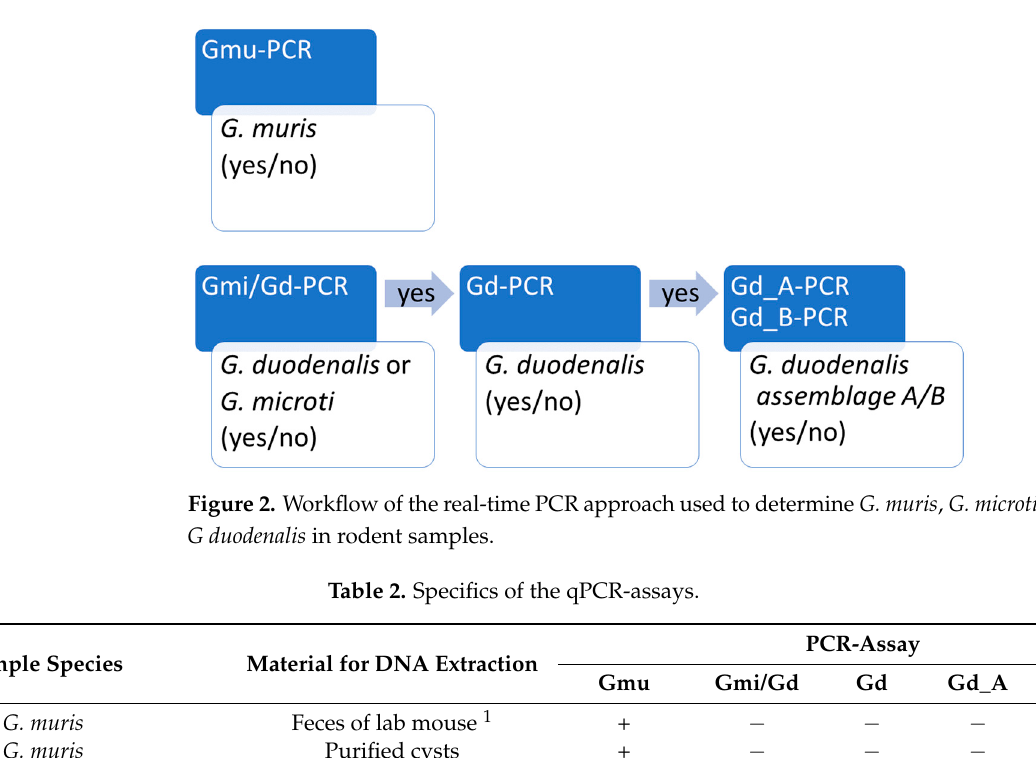
Table 2. Specifics of the qPCR-assays.